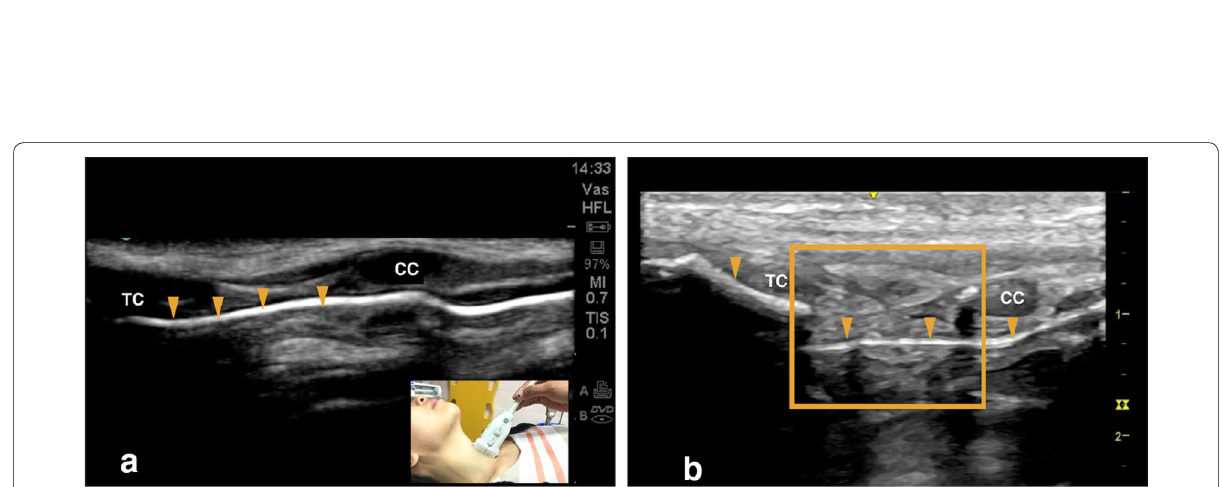
Fig. 4 a Normal sonoanatomy in longitudinal scan showing continuous and intact air–mucosal interface (arrowhead) in relation to thyroid and cricoid cartilage. b Airway ultrasound image in longitudinal scan showing disruption of the air–mucosal interface (arrowhead) and formation of endolaryngeal hematoma and fracture cricoid cartilage (box). TC: thyroid cartilage; CC: cricoid